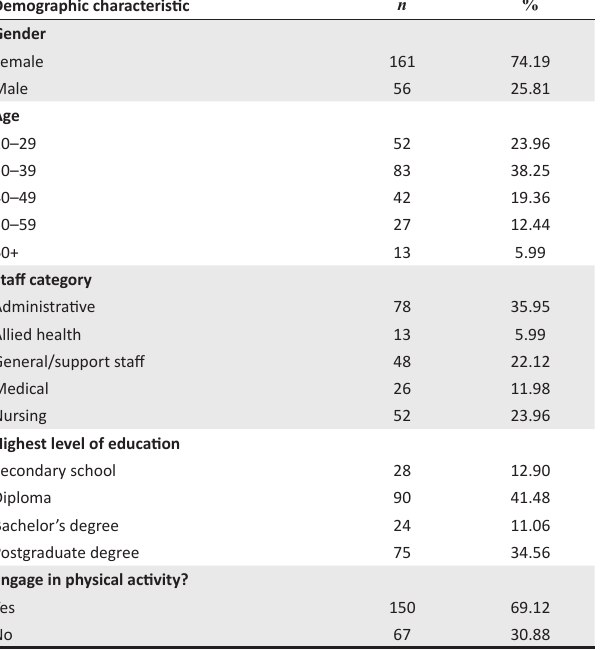
TABLE 1: Demographic characteristics of participants. † Demographic characteristic